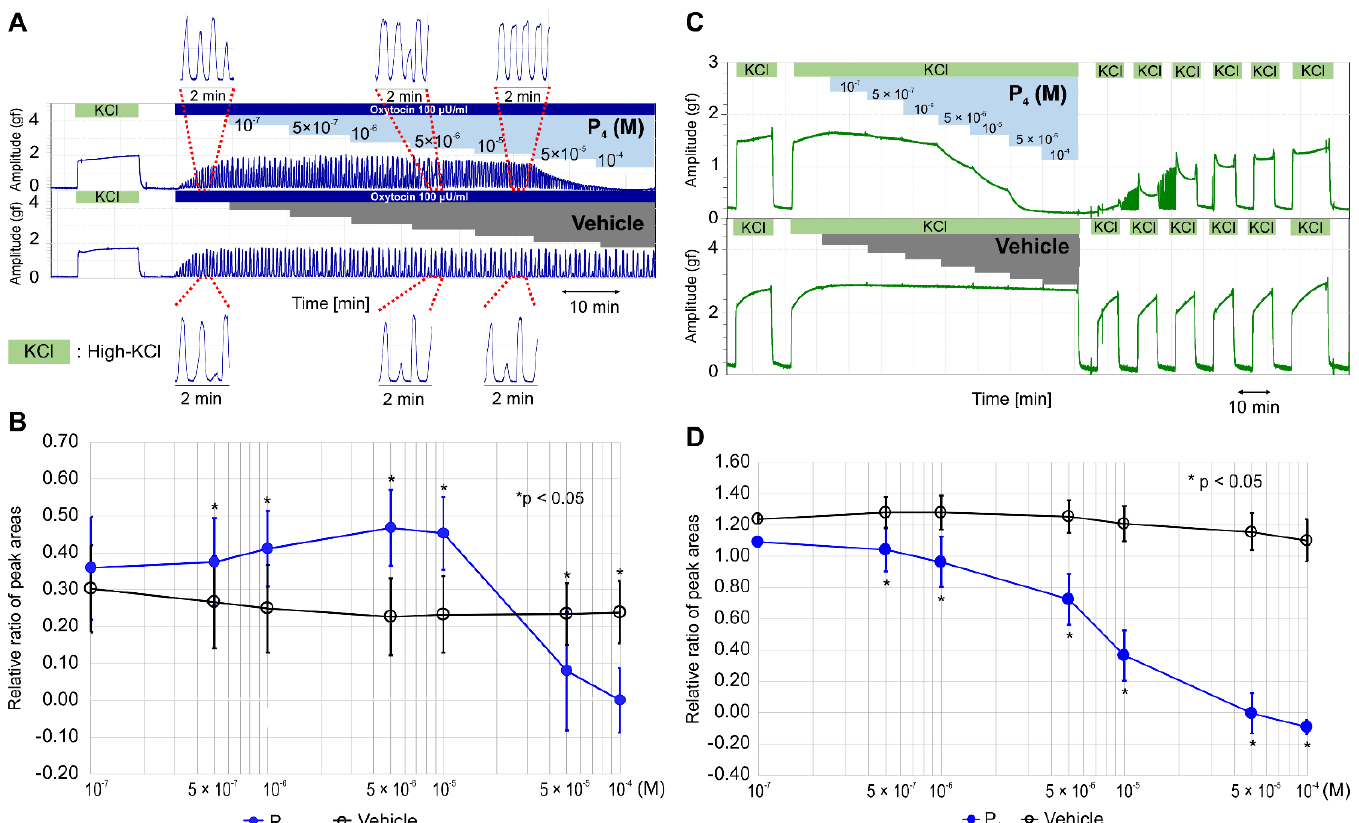
Figure 2. Effects of progesterone on oxytocin- and high-KCl-induced contractions. ( A ) Representative myograph of six myographs obtained when rhythmic contractions were induced by oxytocin (100 µ unit/mL), and progesterone was sequentially added to a physiological saline solution (PSS) at the concentration of 10 − 7 M–10 − 4 M every 10 min after a contraction. ( B ) Time-dependent changes in the relative ratio of the peak area (RRPA) of oxytocin-induced contractions in the progesterone and vehicle groups. ( C ) Representative myograph of six myographs obtained when tonic contractions were induced by high KCl (72.7 mM), and progesterone was sequentially added into the PSS at the concentrations of 10 − 7 M–10 − 4 M every 10 min after a contraction. ( D ) Time-dependent changes in the RRPA of high-KCl-induced contractions in the progesterone and vehicle